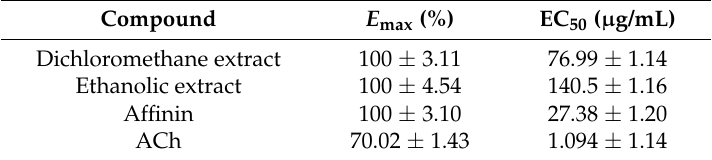
Table 2. Vasodilator effect of Heliopsis longipes roots extracts and affinin on rat aorta.